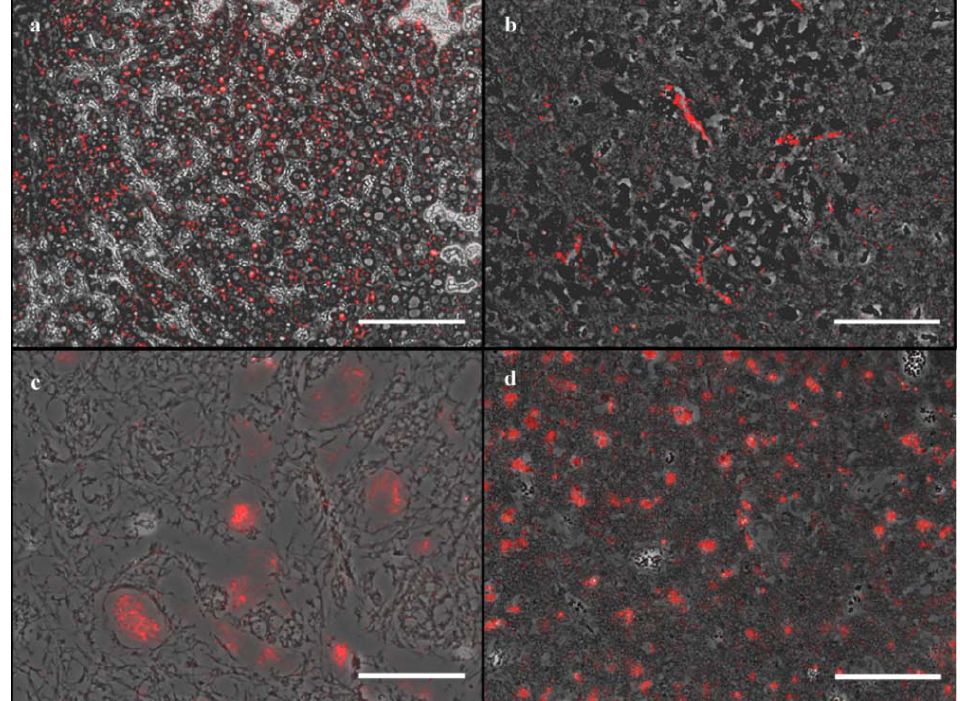
Figure 2. Overview of signals after applying the FISH ‐ RNA probe mix. ( a ) Using the BovHepV specific FISH ‐ RNA probe mix, several hepatocytes of a BovHepV infected bovine, stained positive for BovHepV (bar: 100 μ m); ( b ) SBV was detected in several neurons of the cerebrum using the SBV ‐ specific FISH ‐ RNA probe mix (bar: 100 μ m); ( c ) Single neurons of the cervical spinal cord stained positive for PBoV in a PBoV infected pig (bar: 100 μ m); ( d ) Cortical and medullary lymphocytes of the pulmonary lymph node in an infected pig showed an intracellular PCV ‐ 2 specific signal (bar: 100 μ m).